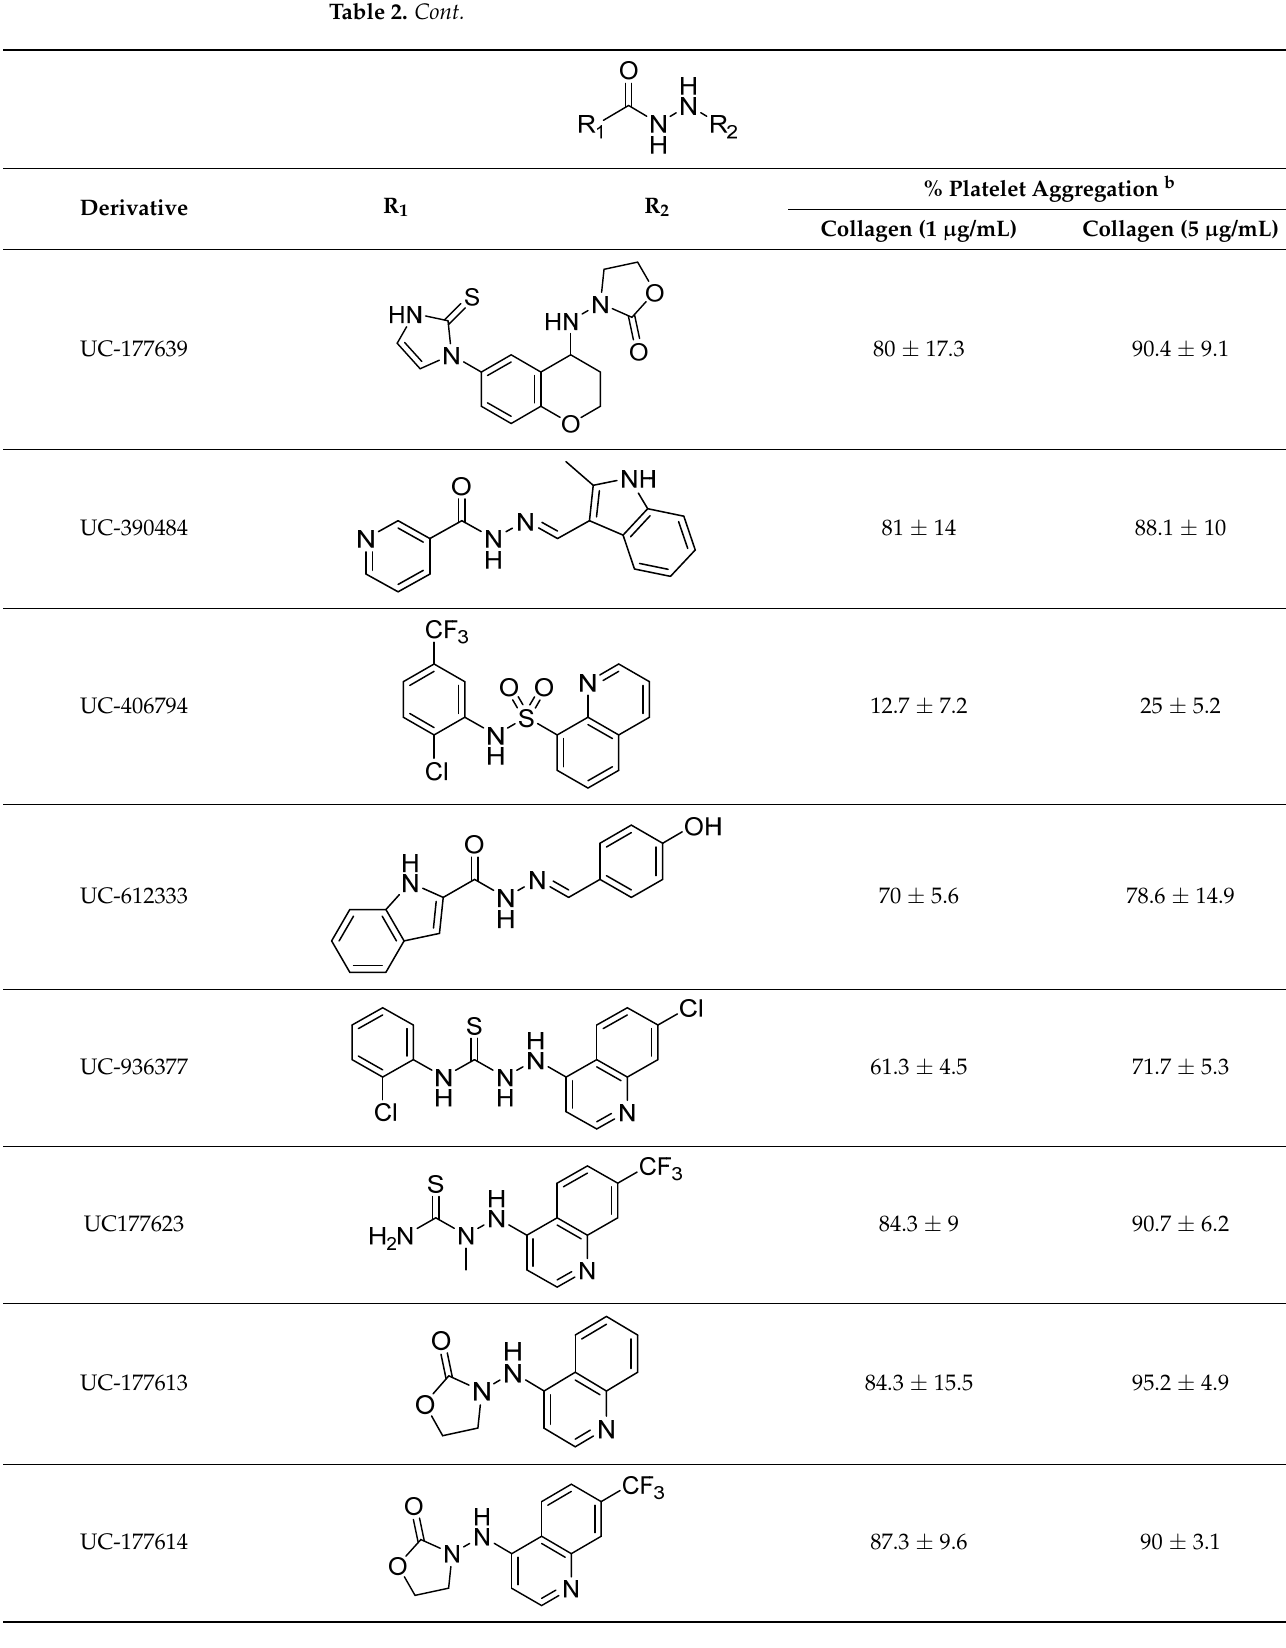
Table 2. Structures of compound UC-177629 analogs and their effects at 20 µM on in vitro collagen- Table 2. Cont. induced platelet